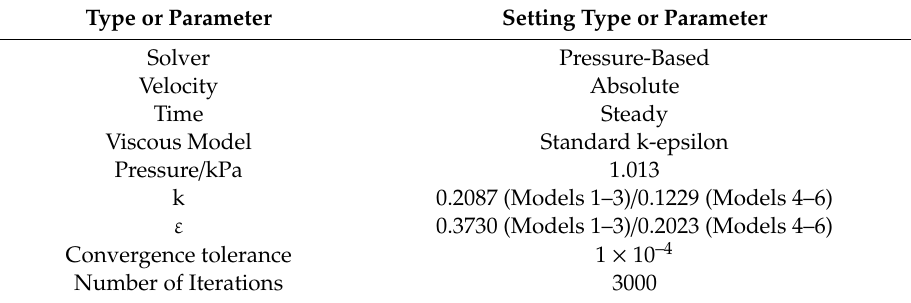
Table 4. Calculation